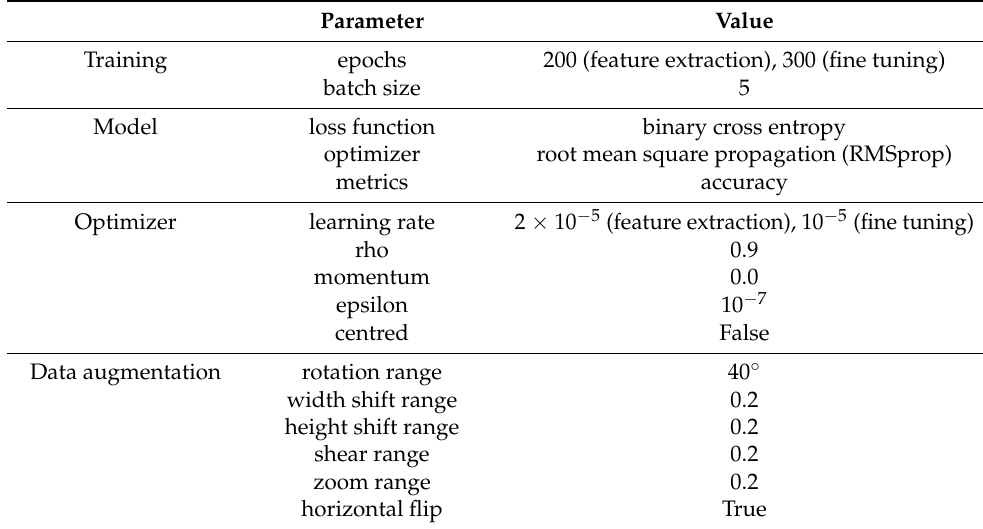
Table 2. Settings used during the models building